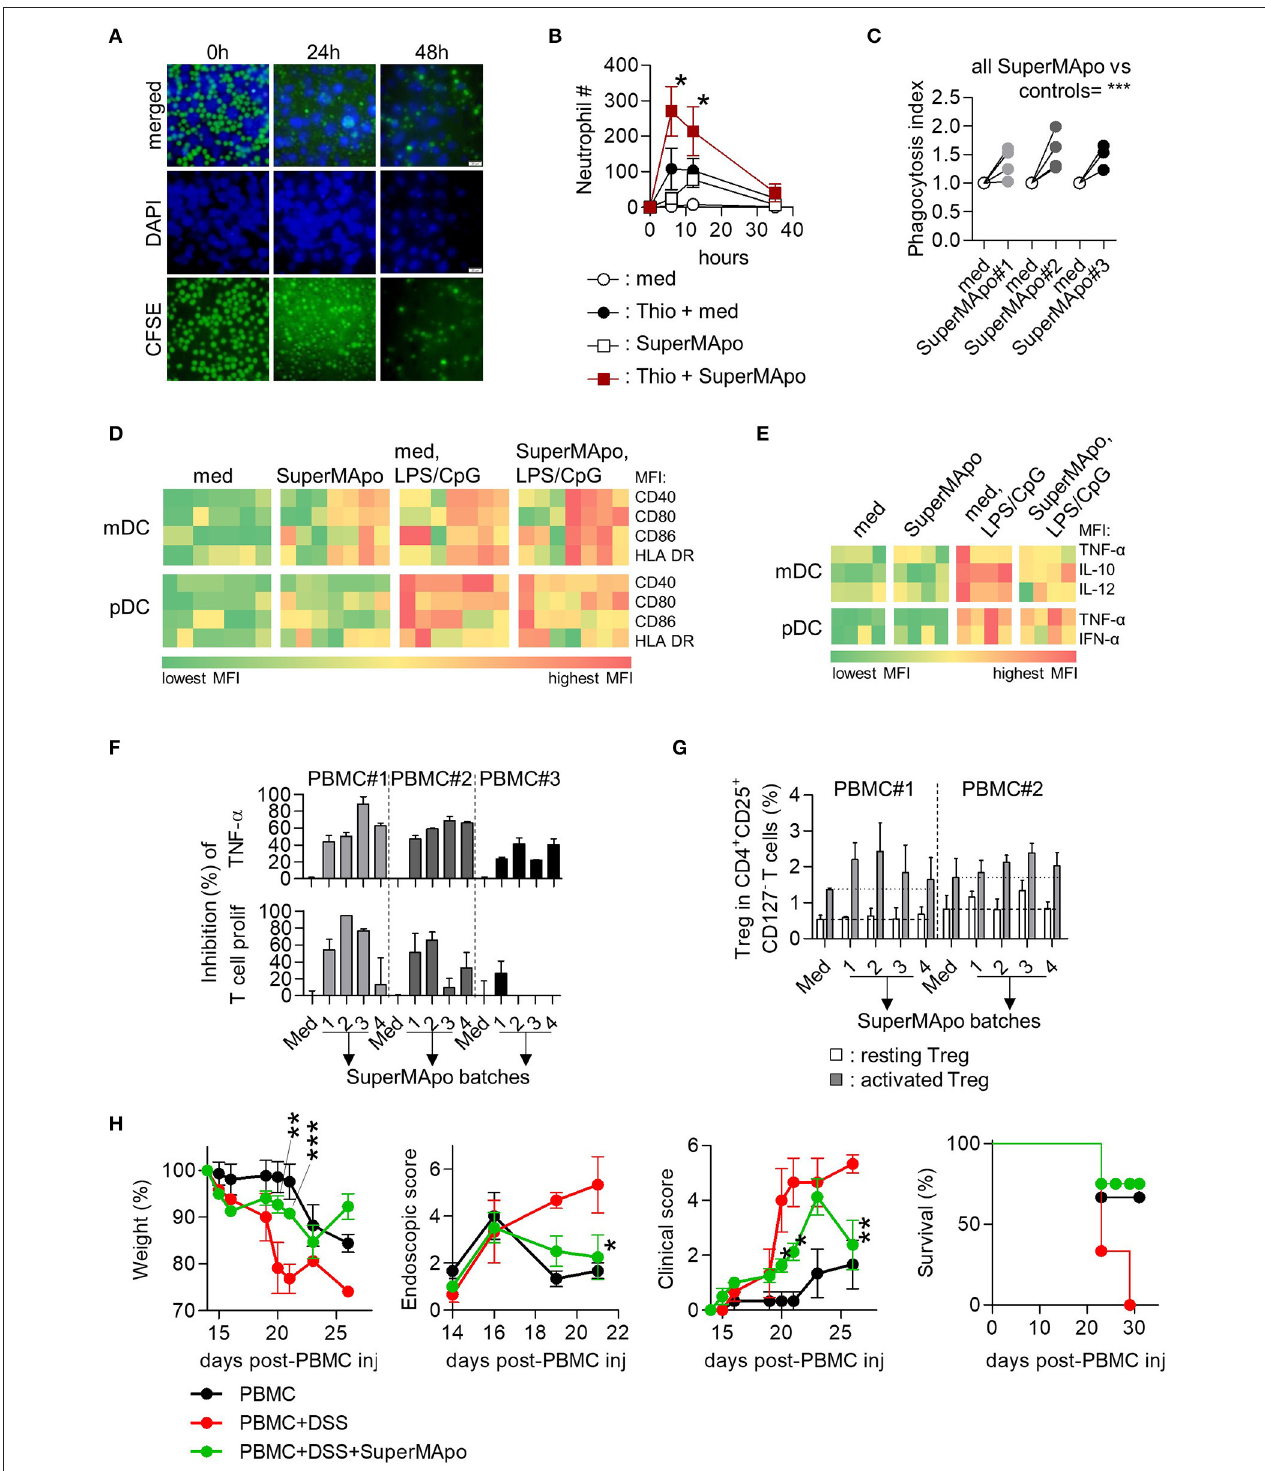
FIGURE 6 | Efferocytosis factors issued from monocyte-derived macrophages demonstrate pro-resolutive properties in vitro and in vivo . (A) Monocyte-derived macrophages were cultured with CFSE-labeled apoptotic PBMC (green) and observed after DAPI staining by inverted fluorescence microscopy at 0, 24, and 48h of culture. (B) Injection (i.p.) of the supernatant from the previous 48h culture (SuperMApo) increased neutrophil number (mean ± s.e.m., n = 2-9 mice per group), 12h after thioglycollate mobilization (Thio + SuperMApo) and control PBMC/neutrophils-reconstituted NSG mice (SuperMApo). * P < 0.05, Kruskal-Wallis test with